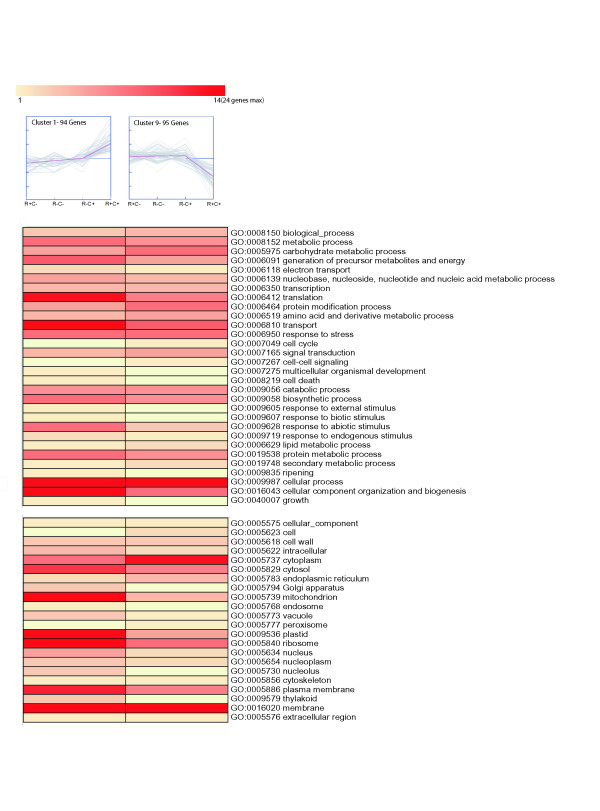
Gene clusters with inverse expression profiles exclusively in woolly fruits. Cluster 1 (left) contains 94 genes that have increased expression exclusively in fruits that are wooly (E4: R+, C+), whereas cluster 9 (right) contains 95 genes with decreased expression exclusively in these same fruits. The Gene Ontology annotations of the genes in these clusters are represented below each cluster. The number of genes associated with each GO term is represented by the color of the bars, as depicted in the scale presented in this figure. The dashed line indicates non-ripe fruits, E1 (R-, C-). To the left of the dashed line is the expression levels for ripe, juicy fruits, E2 (R+, C-). To the right of the dashed line are E3 (R-, C+) and E4 (R+, C+) fruits, non-ripe and ripe fruits that have undergone long-term cold storage, respectively. E4 (R+, C+) fruits are wooly. Annotations correspond to the parental plant GO Slim terms.